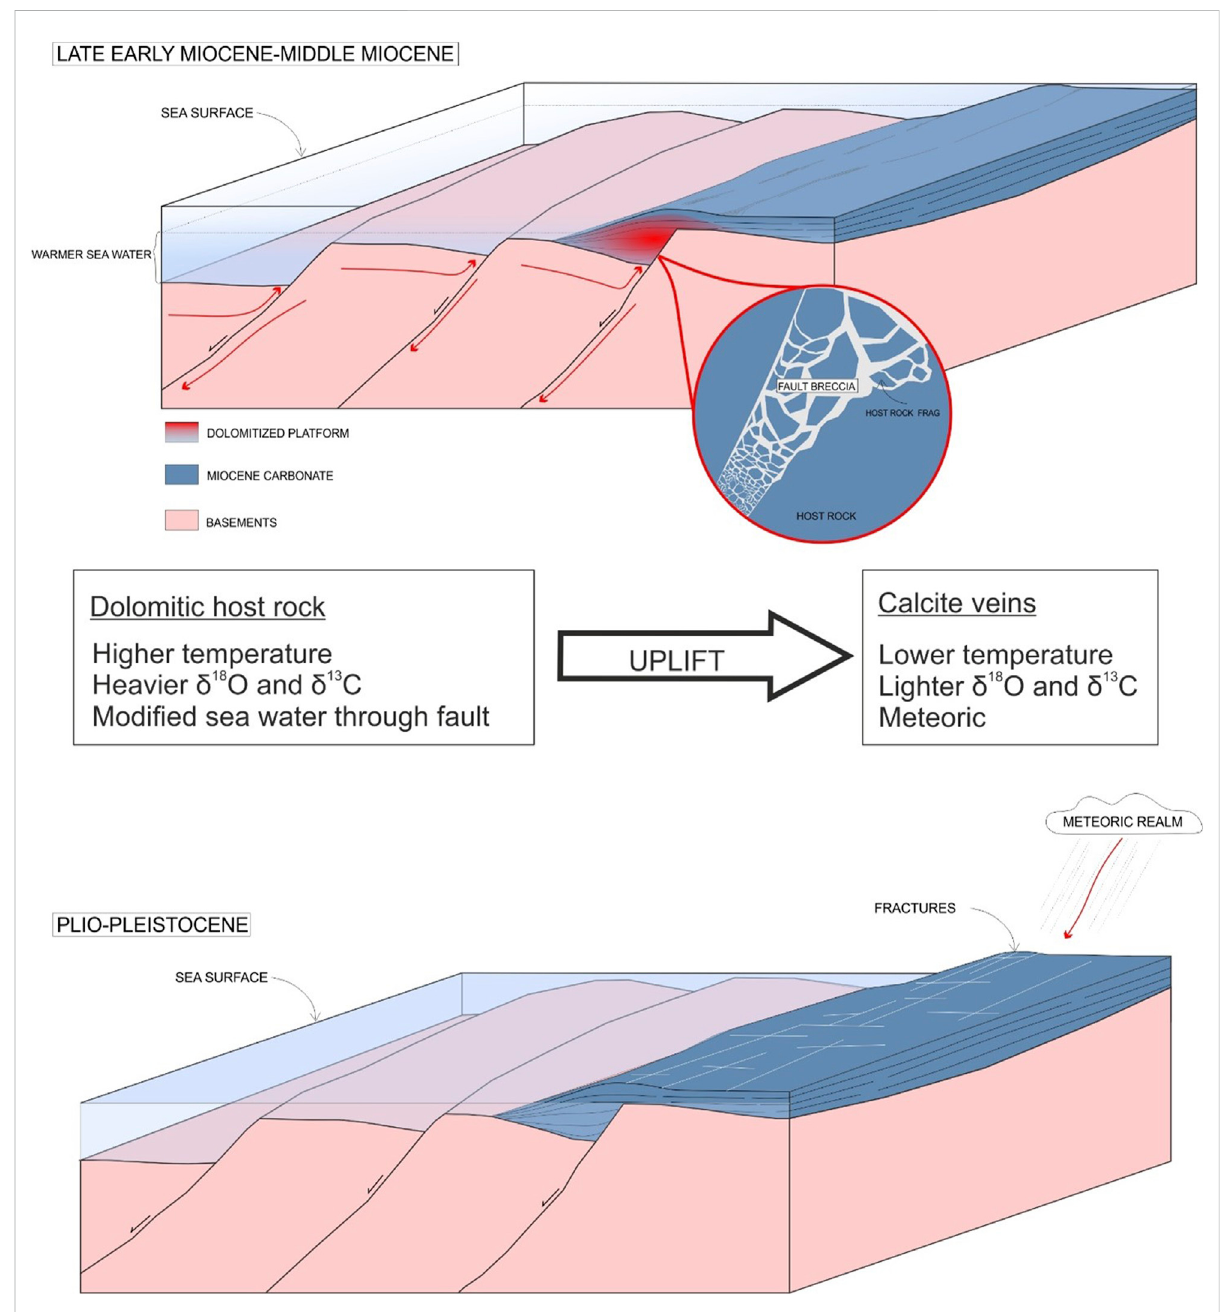
FIGURE 5 DolomitizedmodelschematicdiagramoftheUmmLujstudyareaduringtheMiocene,thenupliftinthePlio-Pleistocene.Thelatercalciteveins indicated the meteoric isotopic signal was encountered from the study